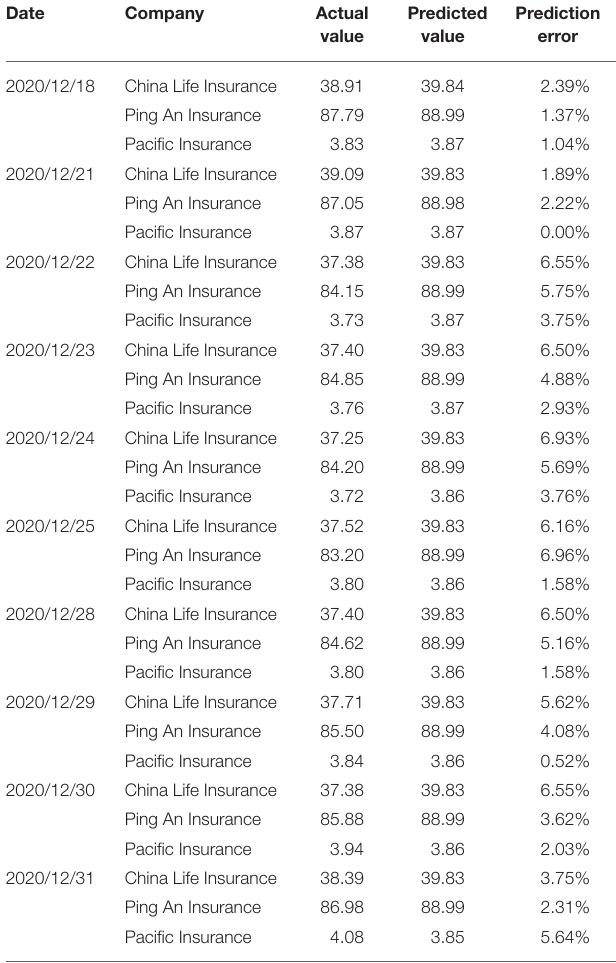
TABLE 2 | Prediction results and errors of stock prices of three health insurance companies.